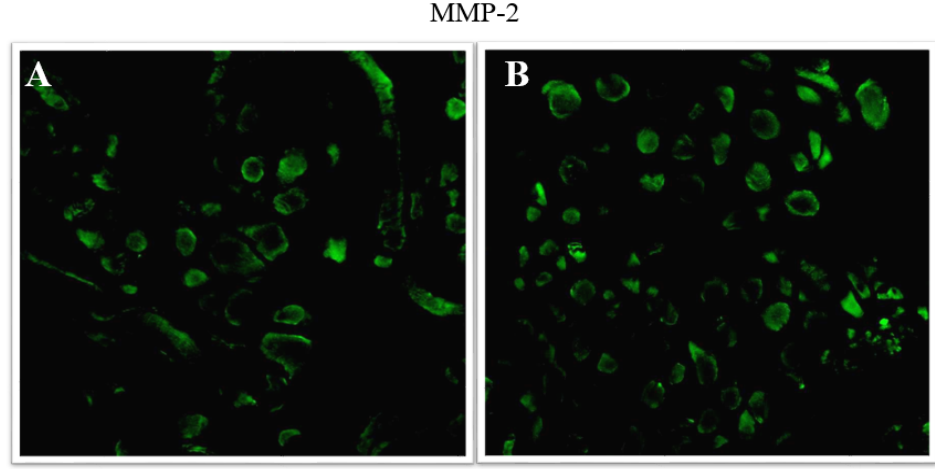
Figure 3. Immunofluorescence reactions anti MMP-2 (green fluorescence) in contralateral ( A ) and ipsilateral ( B ) masseter muscle of patients affected by unilateral posterior crossbite. There is no difference in MMP-2 staining pattern between contralateral and ipsilateral muscles. p -value > 0.05.